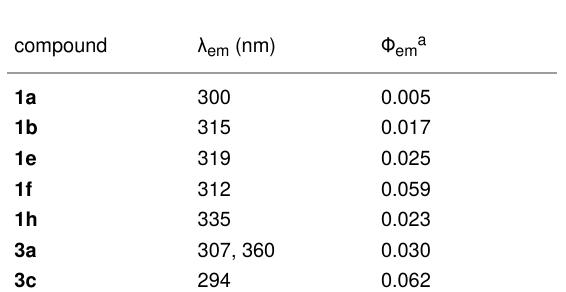
Table 2: Emission data of selected diaryl- and triaryl phosphates 1 and 3 .